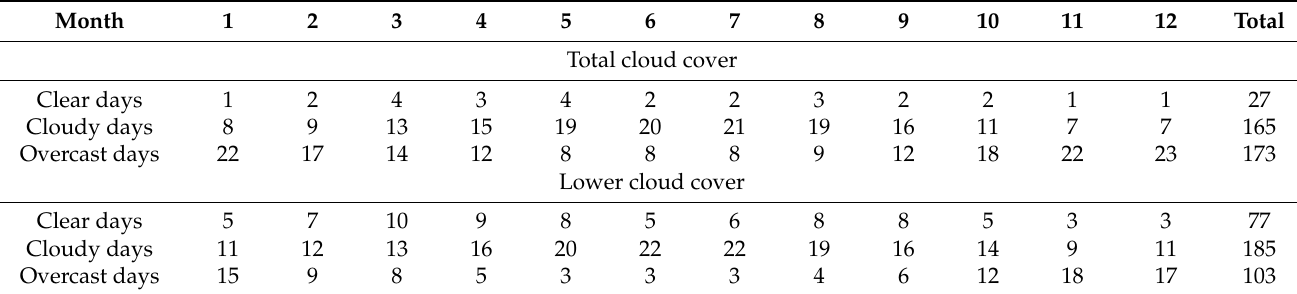
Table A6. Distribution of clear and cloudy days within the